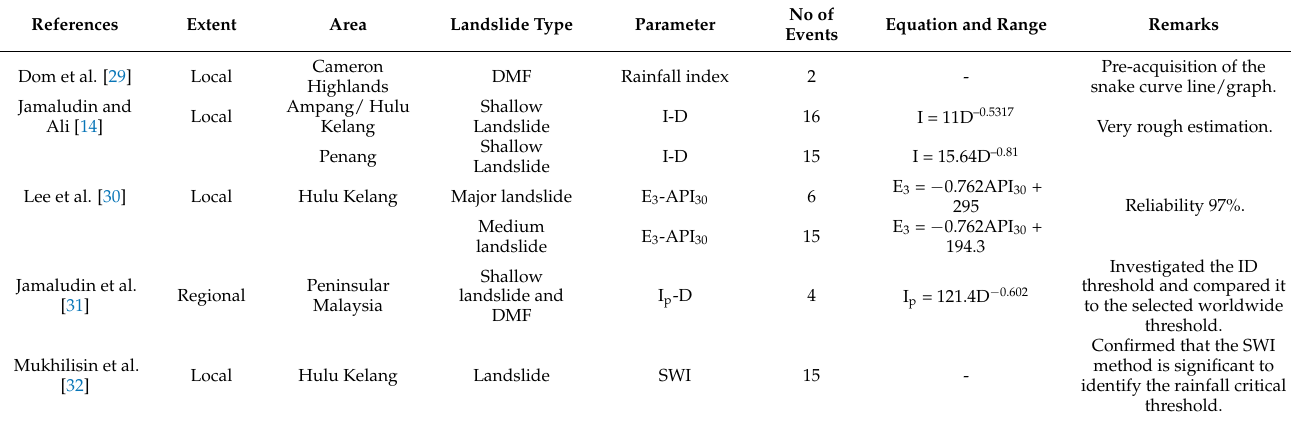
Table 2. Studies on rainfall thresholds in Malaysia for landslides (2006–2020).